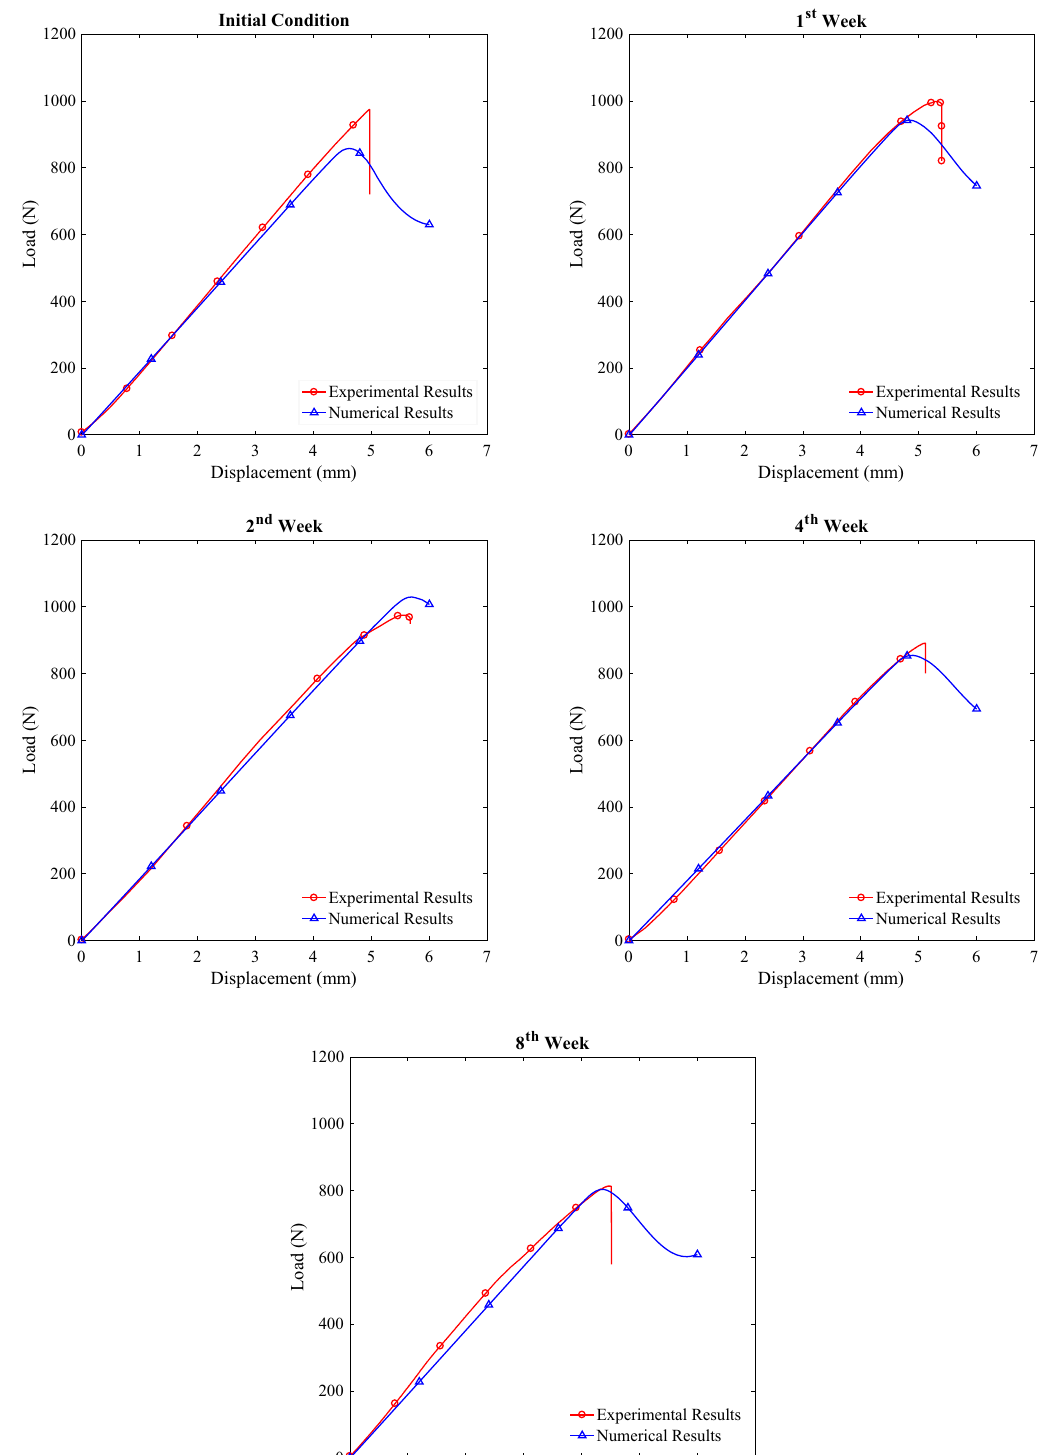
Figure 10: Numerical and experimental load – displacement curves of specimens exposed to the acidic solution at